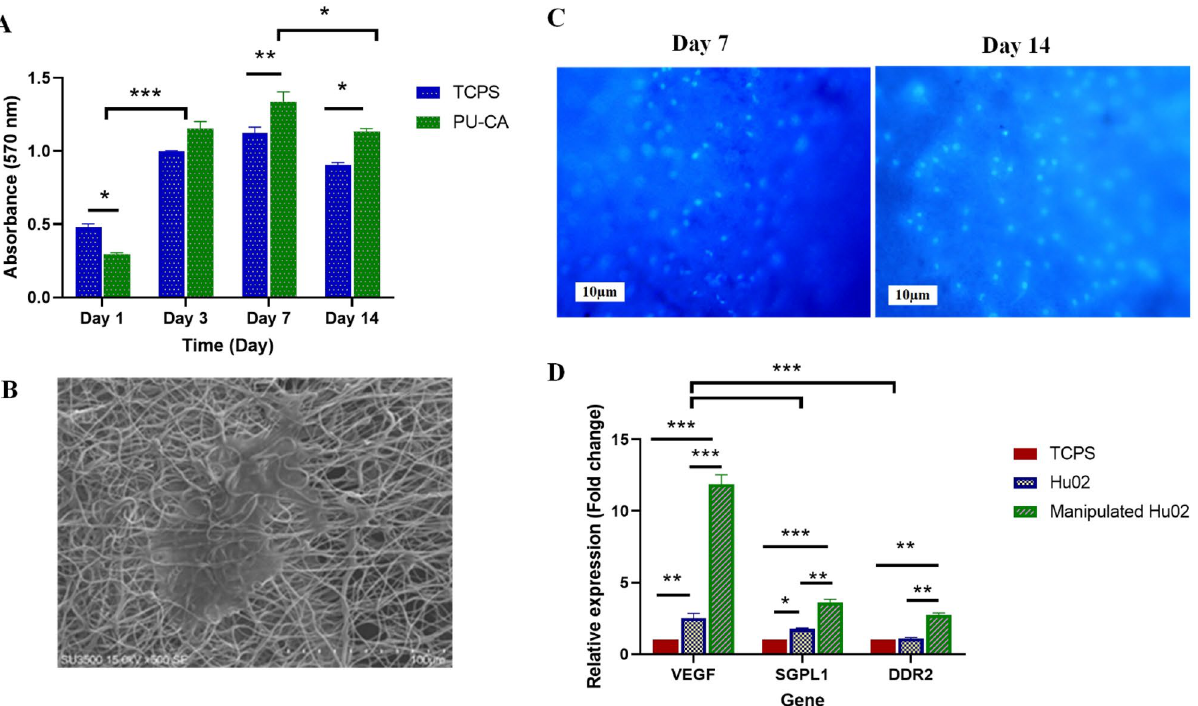
Figure 6. ( A ) Viability of fibroblasts seeded on scaffold and TCPS as control during the 14 days, ( B ) SEM images of fibroblasts on the surface of the PU-CA scaffold 3 days after cell culture. ( C ) DAPI staining after culture of cells on days 7 and 14. ( D ) VEGF , DDR2 , and SGPL1 gene expression at mRNA level. Three days after cell seeding on scaffold and TCPS the cells of each group were tested by Real-Time PCR. Manipulated cells showed more expression in certain genes compared to Hu02 and TCPS groups. (* P ≤ 0.05, ** P ≤ 0.01, *** P ≤